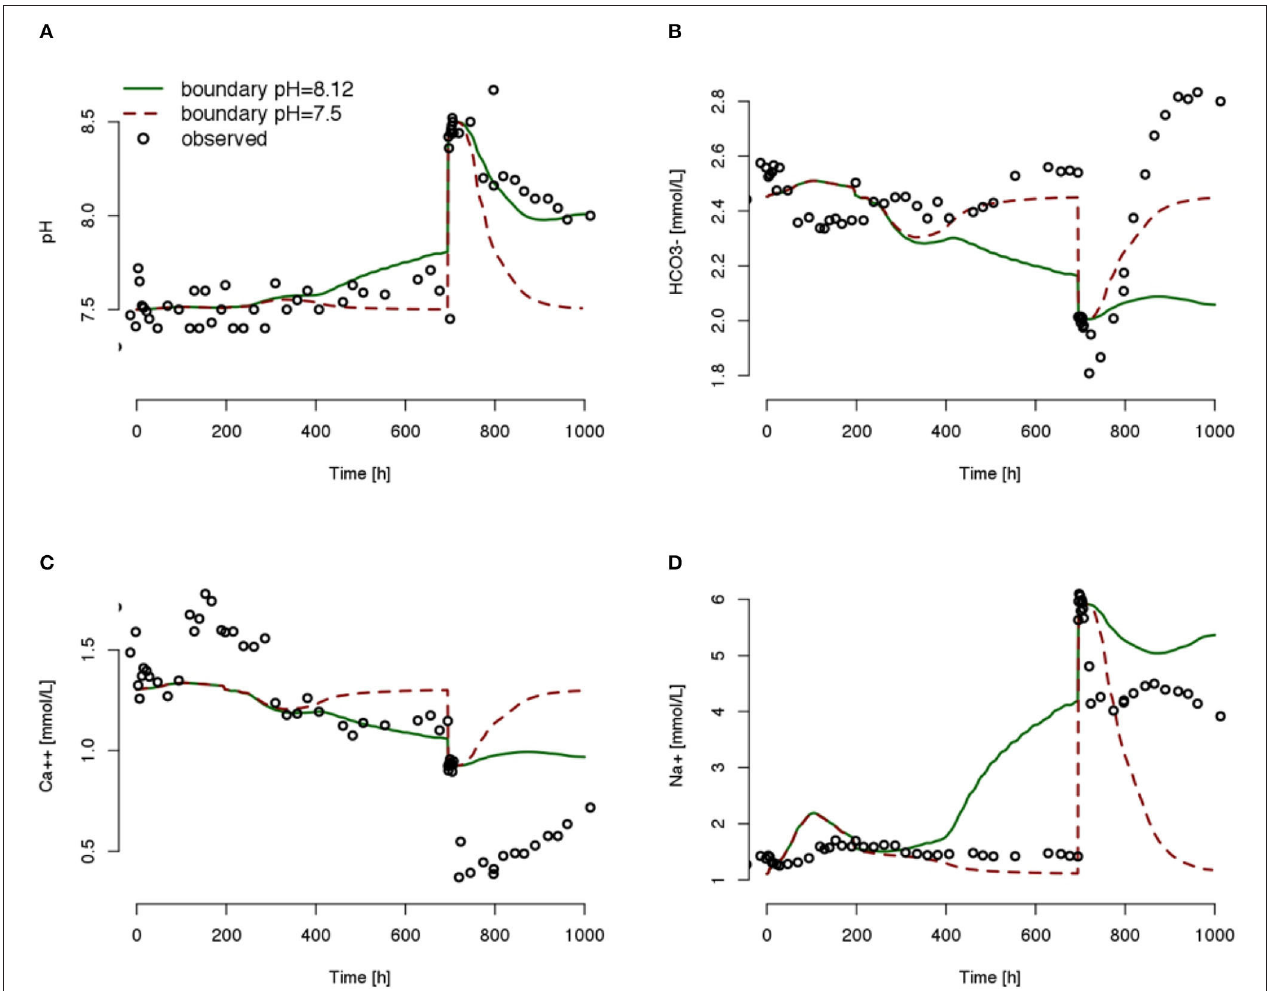
FIGURE 11 | Simulated and observed geochemical conditions, pH (A) , HCO3 − (B) , Ca ++ (C) , and Na + (D) at well 2–28. Simulation results are adopted from one realization of the set of simulations that produced Figures 8 , 9